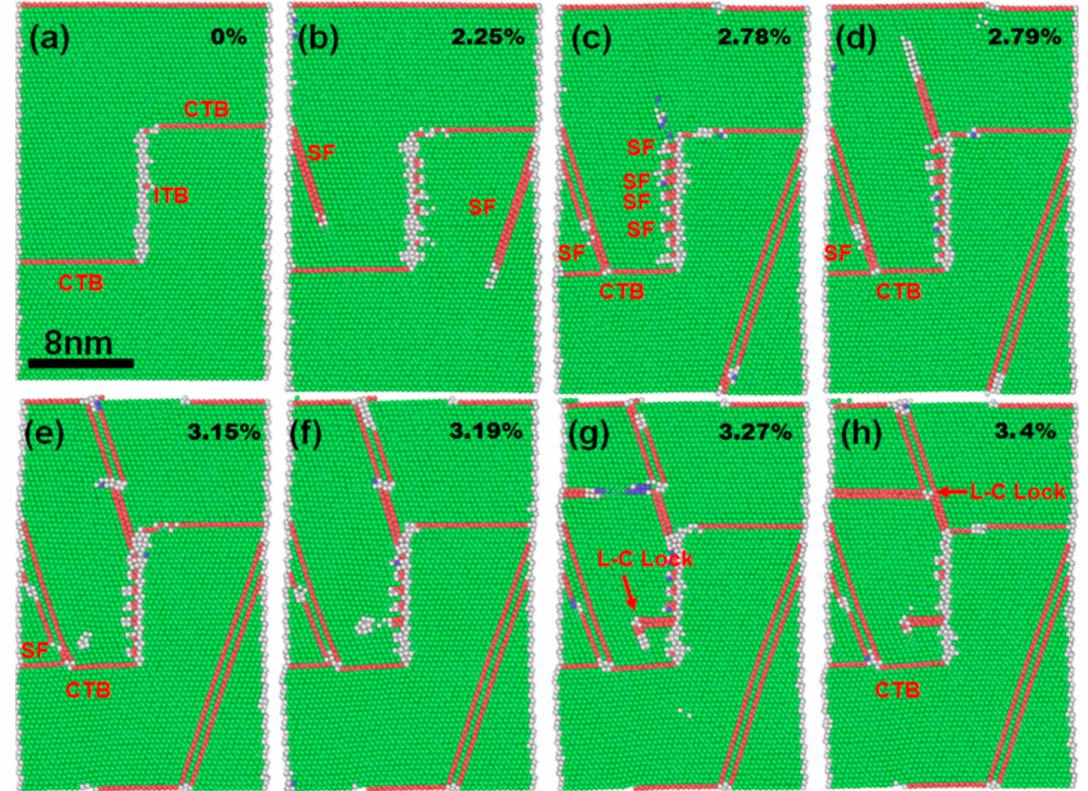
Figure 3. Atomic image of a twin-structured Au nanocrystal with tensile strains of 0%, 2.25%, 2.78%, 2.79%, 3.15%, 3.19%, 3.27%, and 3.4%. ( a – d ) Partial dislocations nucleate from the free surface and intersect the CTB; ( e , f ) two partial dislocations react with each other to form a L–C lock; ( g , h ) with further straining, a new partial dislocation intersects with the previous generated SF to form another L–C lock; at the same time, the first L–C lock is destroyed. Red: hexagonal close-packed atoms; green: FCC atoms; gray: other types of